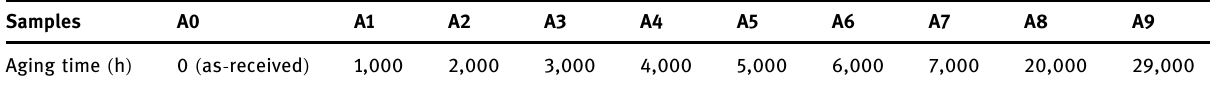
Table 2: Aging time of P92 steel samples at 650°C Samples